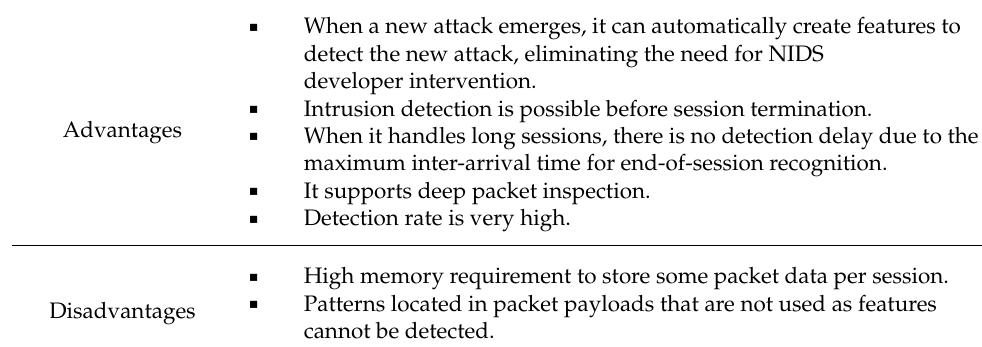
Table 3. Advantages and disadvantages of packet-feature-based